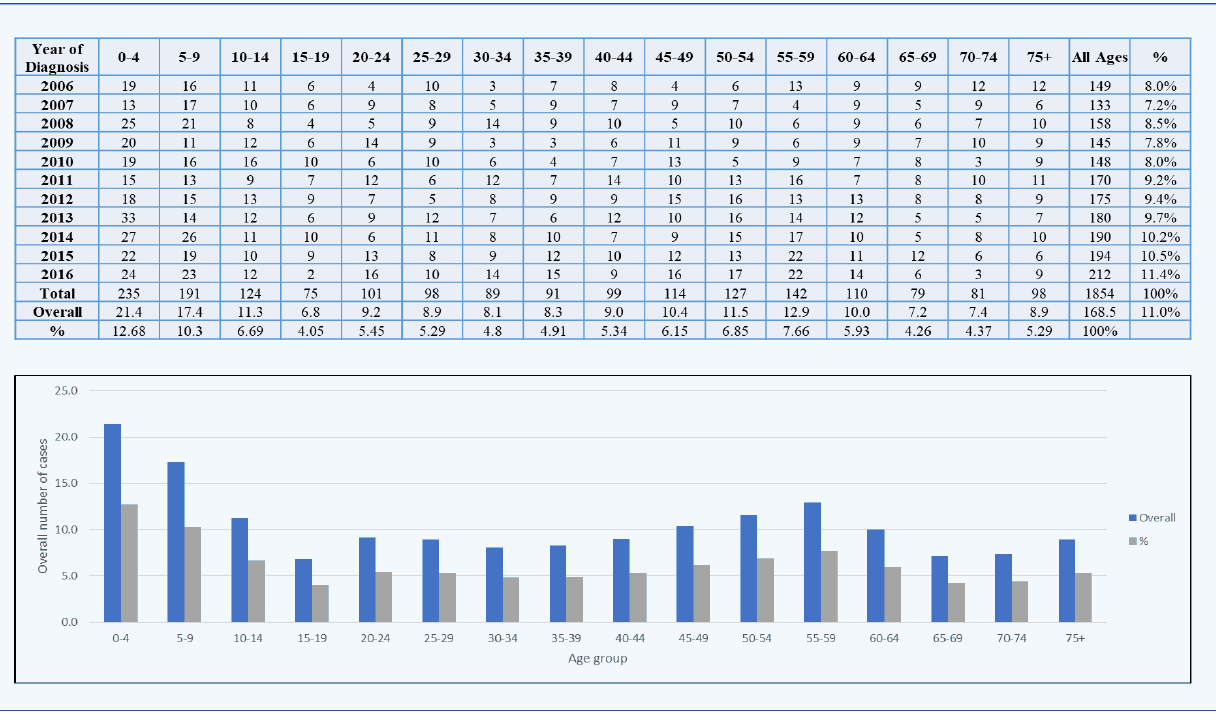
Figure 1. Numbers and percentages of brain tumors in males from 2006 - 2016.